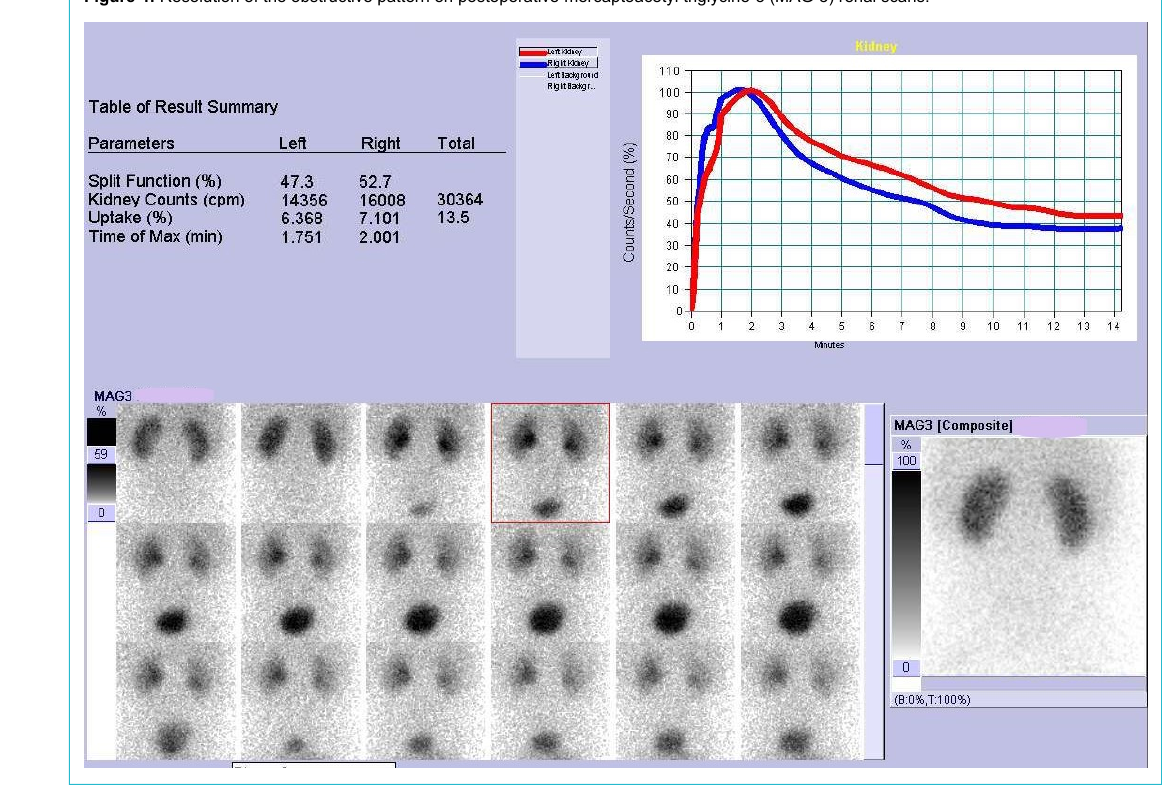
Figure 4: Resolution of the obstructive pattern on postoperative mercaptoacetyl triglycine-3 (MAG-3) renal